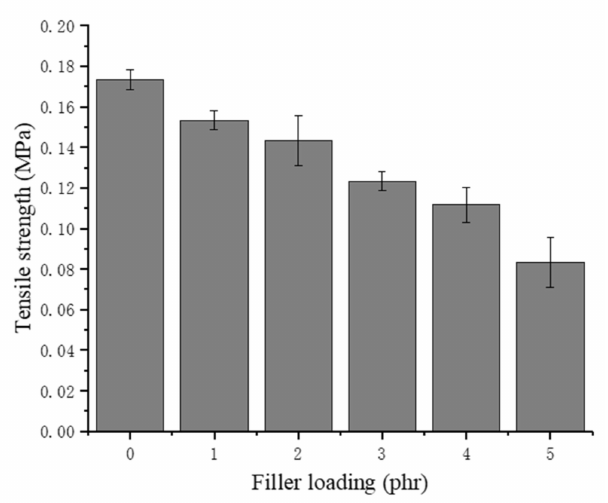
Figure 8. Tensile strength of